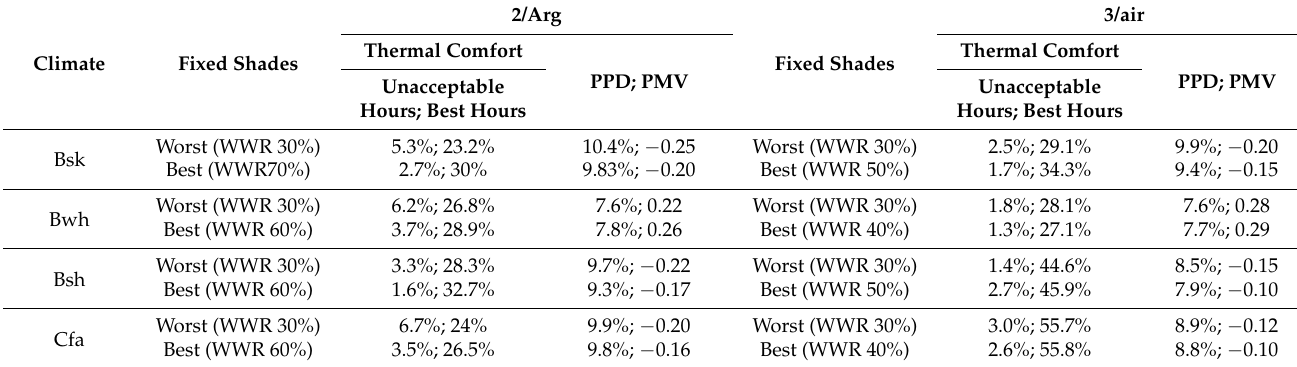
Table 4. Best and worst WWR based on thermal comfort analyses for warm climate conditions.